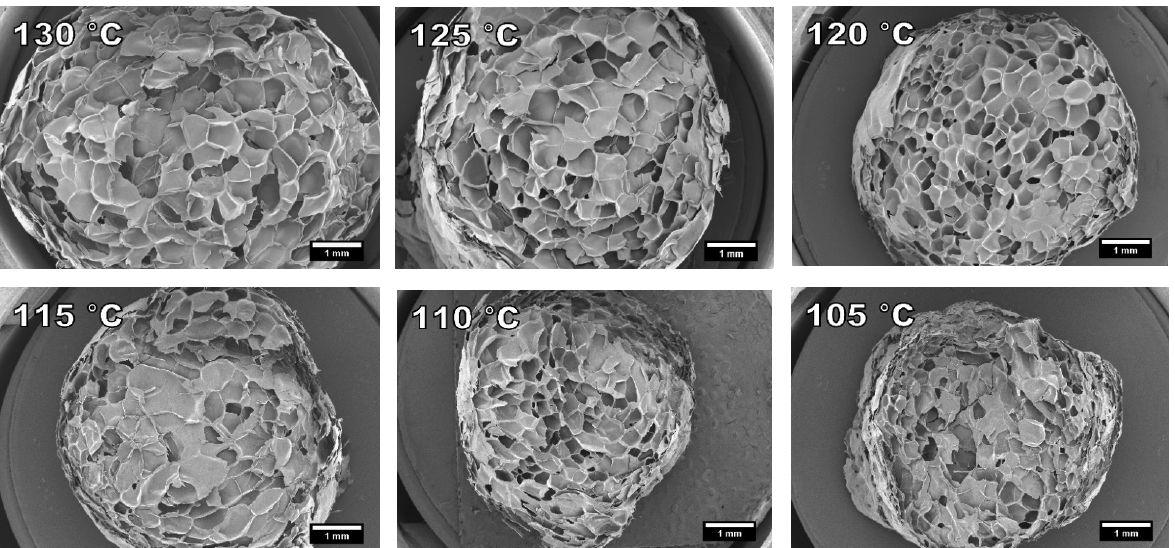
Figure 7. SEM images of prepared cellulose palmitate foams using different foaming temperatures and 3% IB as a blowing agent. Refer to Table 3. (15× magnification).